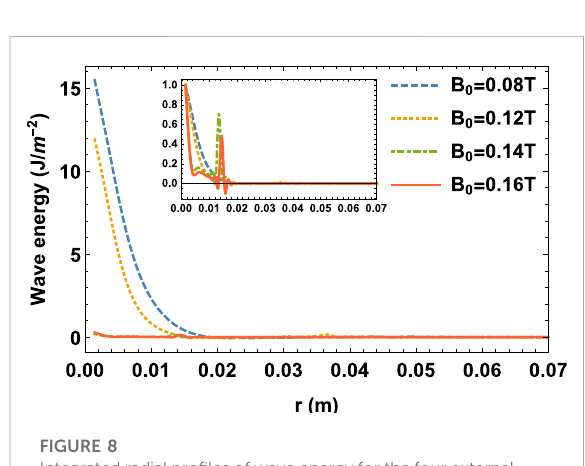
FIGURE 8 Integrated radial pro fi les of wave energy for the four external magnetic fi eld strengths. The inset shows normalised